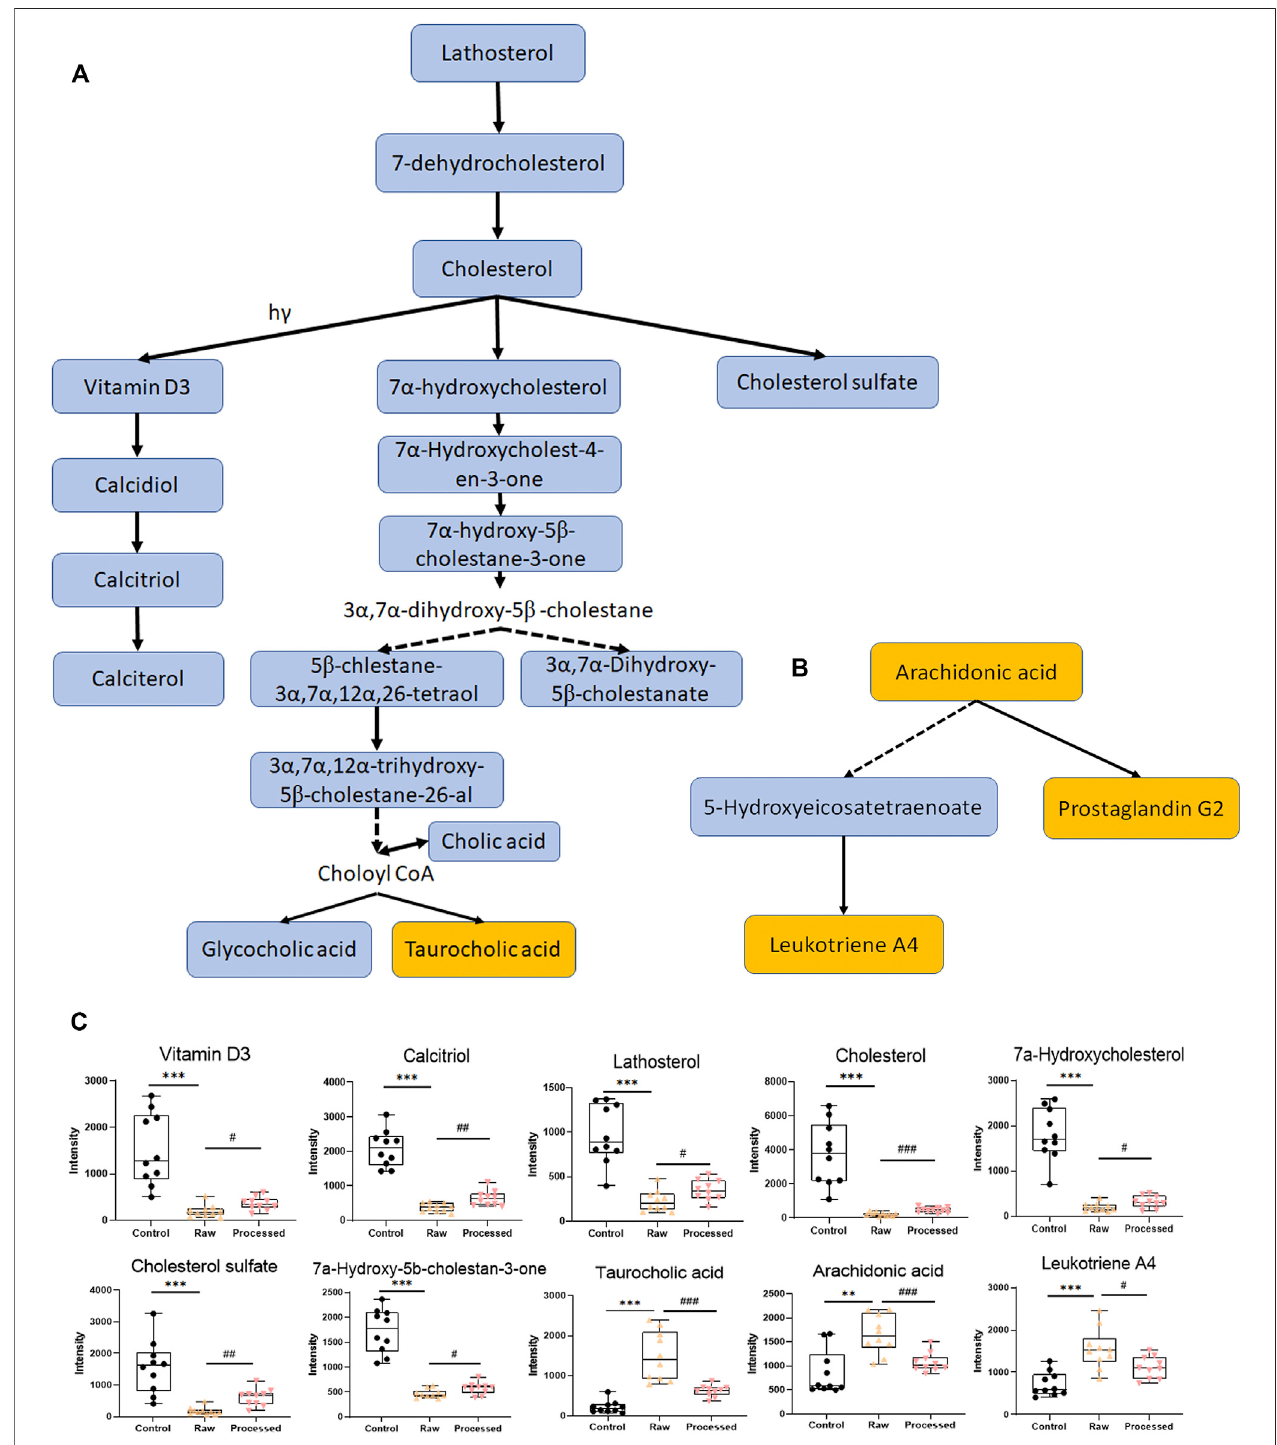
FIGURE 3 | Typical disturbed pathways and relative intensity patterns of metabolites after 4 weeks of high-dose raw TR and processed TR administration. (A) Steroid biosynthesis pathway and primary bile acid biosynthesis pathway, (B) arachidonic acid metabolism, (C) relative intensity of typical disturbed metabolites. Data wereexpressed asmeans ± standard error ofthemean (n= 10). * p < 0.05, ** p < 0.01, and *** p < 0.001 forthe comparison ofthe rawTR and control groups. # p < 0.05, ## p < 0.01, and ### p < 0.001 for the comparison of the processed TR and raw TR groups. Upregulated pathways are labeled in yellow, and downregulated pathways are labeled in